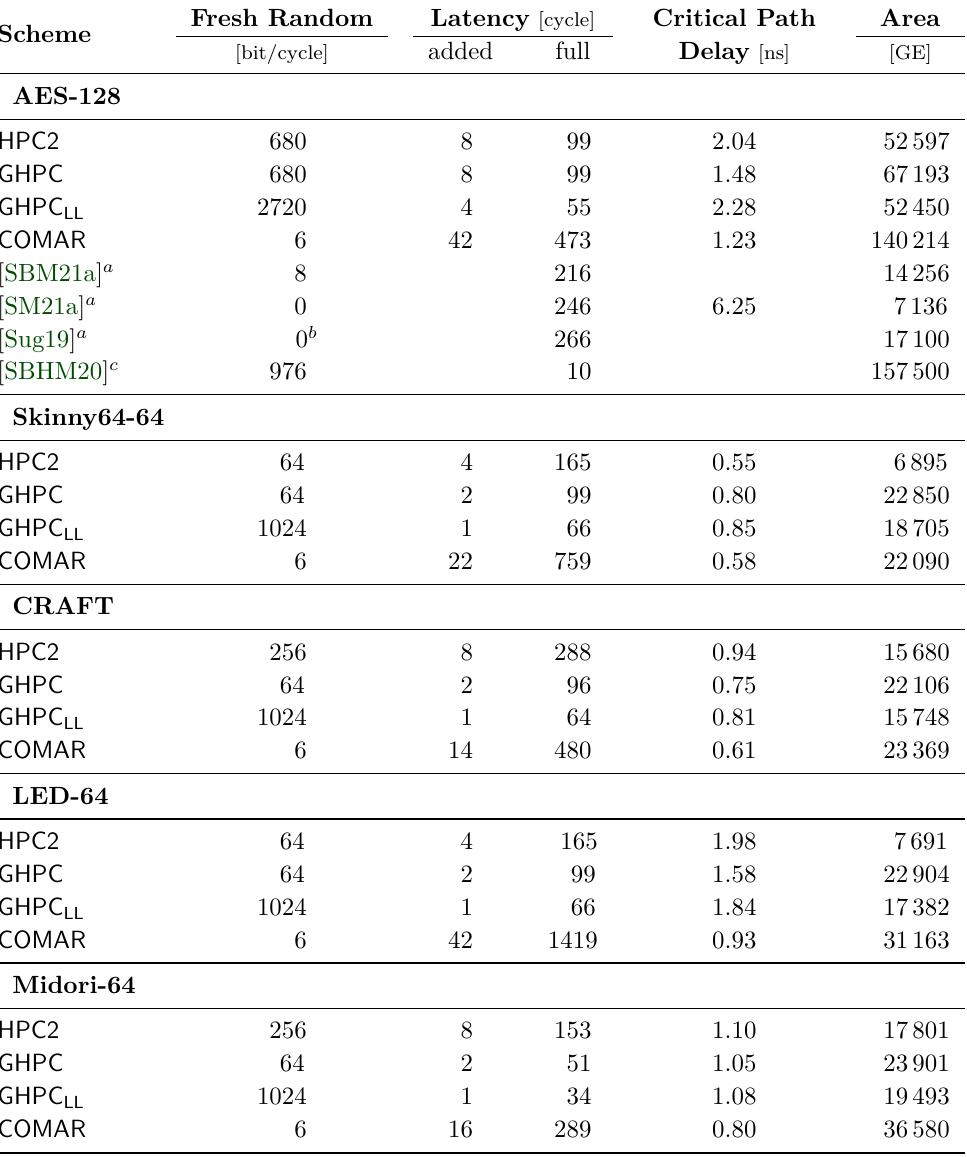
Table 1: Performance figures of first-order round-based full cipher encryption functions, excluding